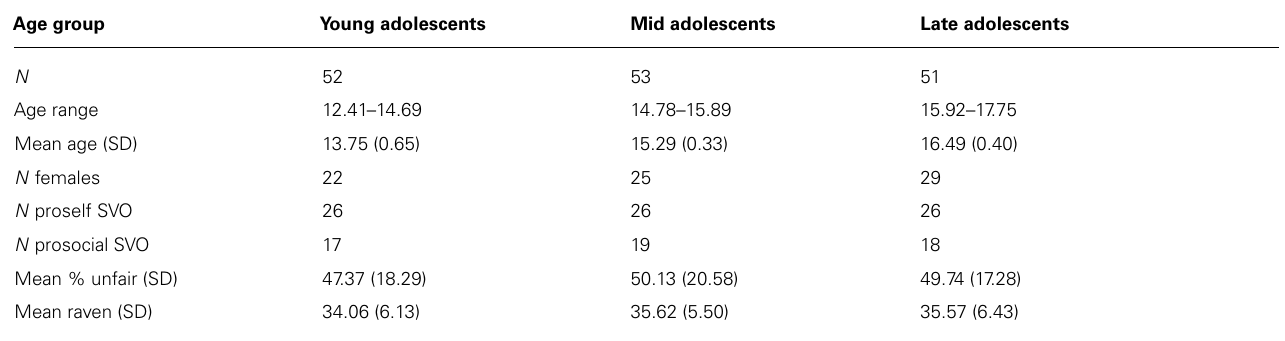
Table 1 | Demographic characteristics of the three age groups.